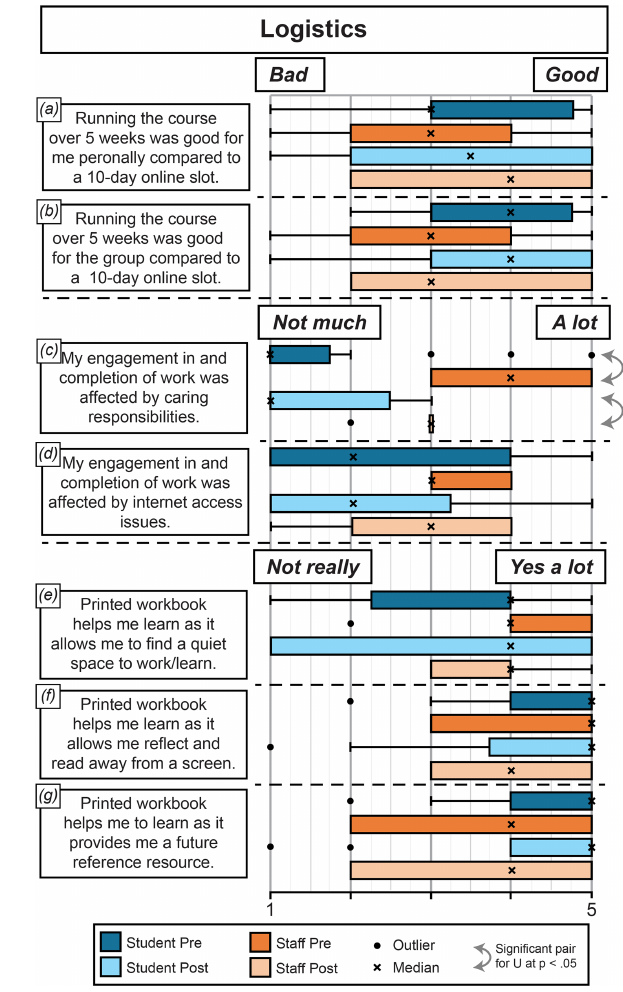
Figure 4. Quantitative responses to logistics statements. Panels (a) and (b ) summarize staff and student responses to statements related to the length of the virtual field trip on a scale of 1–5: 1 is bad, and 5 is good. Panel (c) summarizes staff and student responses to statements related to the impact of internet access issues upon the completion of the course on a scale of 1–5: 1 is not much, and 5 is a lot. Panels (d) – (f) summarize staff and student responses regard- ing the usefulness of printed workbooks on a scale of 1–5: 1 is not really, and 5 is a lot. Responses are grouped by statement and pre- sented as pre-course and post-course responses for the student and staff